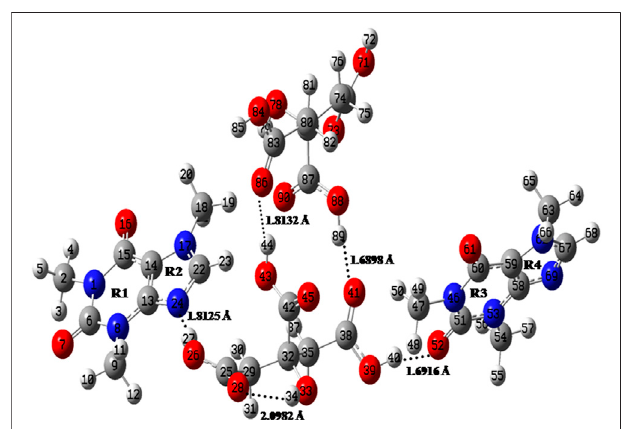
FIGURE 2 | Optimized structure for dimer model of cocrystal with the atomic numbering scheme adopted in the present